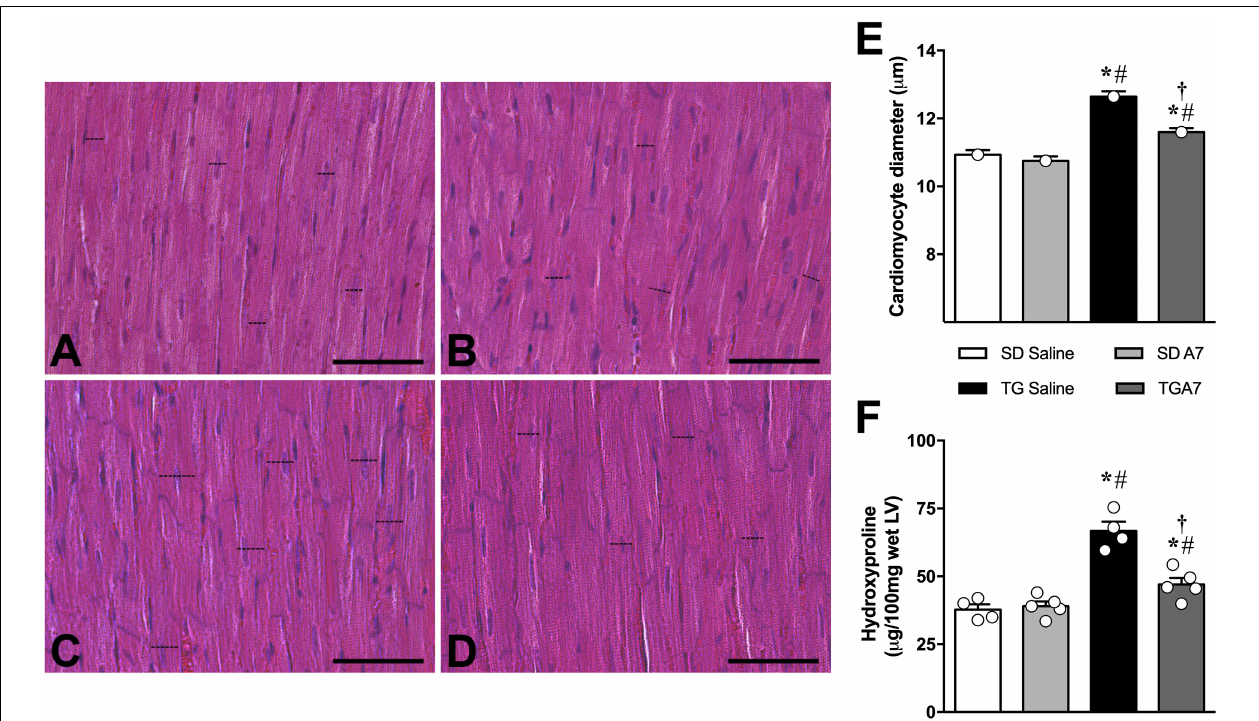
FIGURE 1 | Representative photomicrographs of sections of the left ventricle of sections control (SD saline, n = 5); (A) , control treated with Ang-(1-7) (SD A7, n = 4); (B) , hypertensive rats control (TG saline, n = 4); (C) and hypertensive rats treated with ICV Ang-(1-7) (TG A7, n = 5); (D) . Bar = 20 µ m. Stain: hematoxylin/eosin. The cardiomyocyte diameter (E) of the free wall LV and Hydroxyproline as a fibrotic marker (F) . * p < 0.05 vs. SD saline; # p < 0.05 vs. SD A7; † p < 0.05 vs. TG saline (One-way ANOVA followed by Newman-Keuls post hoc